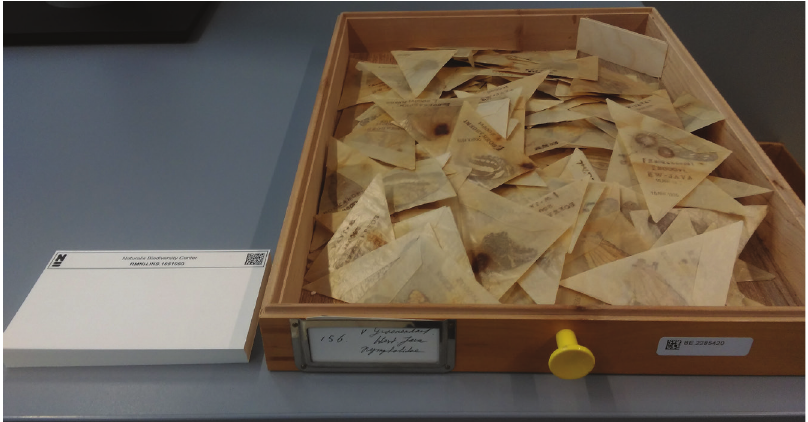
Figure 3. A drawer with papered Lepidoptera that has been prepared by the project coordinator for the volun - teers. Next to the drawer is a stock of acid free labels which will be adjoining the